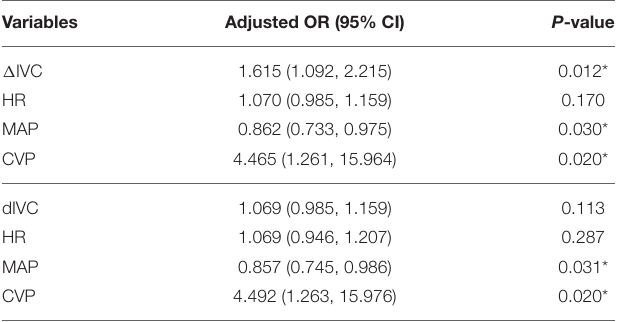
TABLE 3 | Multivariate analysis of the predictors for volume